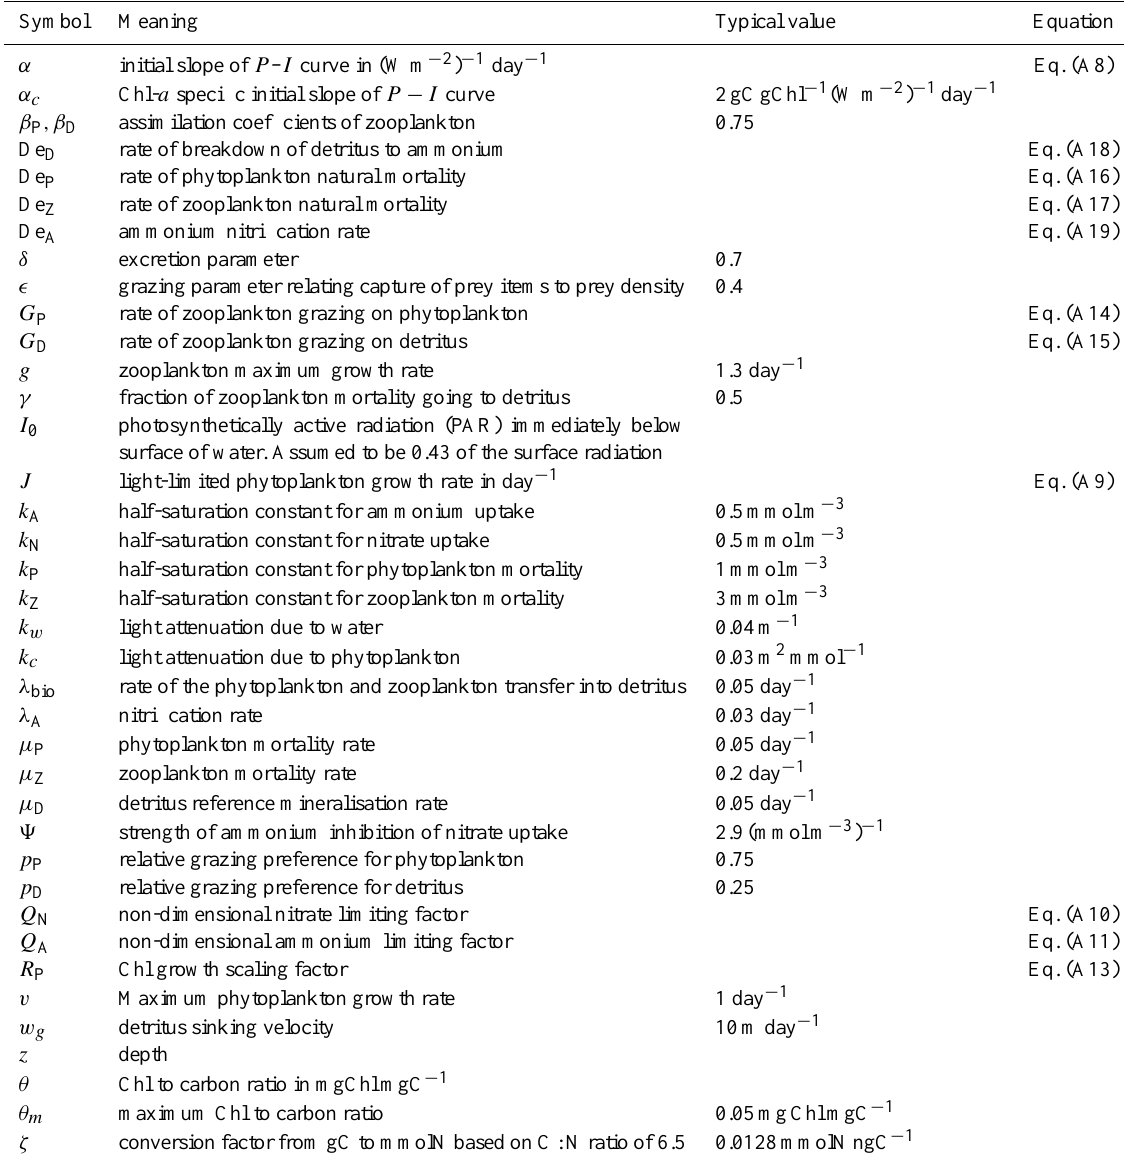
Table A1. Symbols used to describe the six-component NPZD model. Typical values are provided for externally set parameters. Symbol Meaning Typical value Equation α initial slope of P – I curve in (Wm − 2 ) − 1 day − 1 Eq. (A8) α c Chl- a specific initial slope of P − I curve 2gCgChl − 1 (Wm − 2 ) − 1 day −